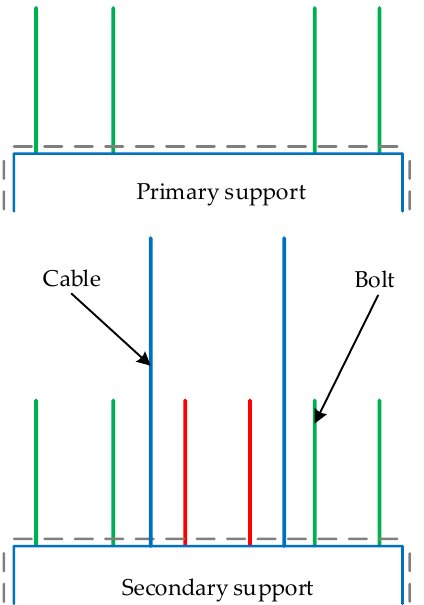
Figure 11. Schematic diagram of roof support completed in two steps.